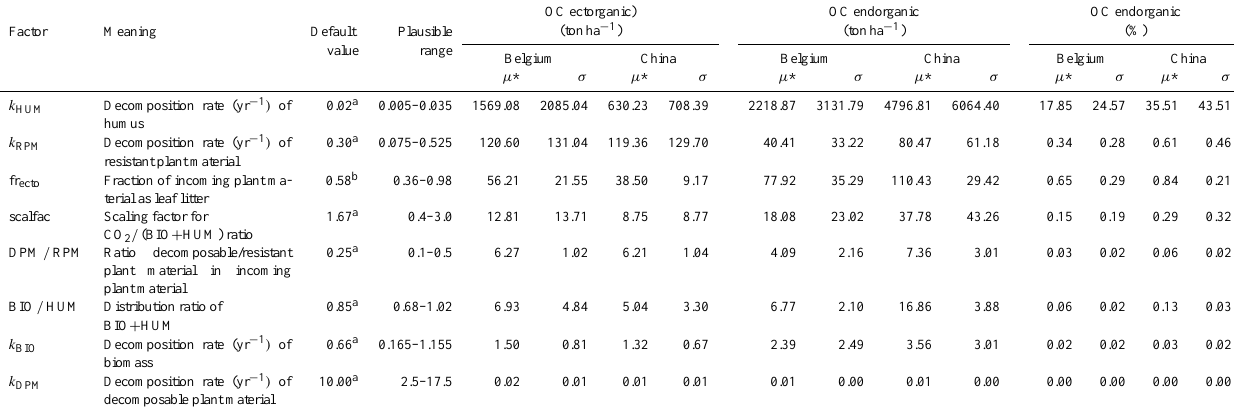
Table 2. Model parameters in the organic C-module in SoilGen2 and results of sensitivity analysis. OCectorganic) OCendorganic OCendorganic Factor Meaning Default Plausible value range Belgium China